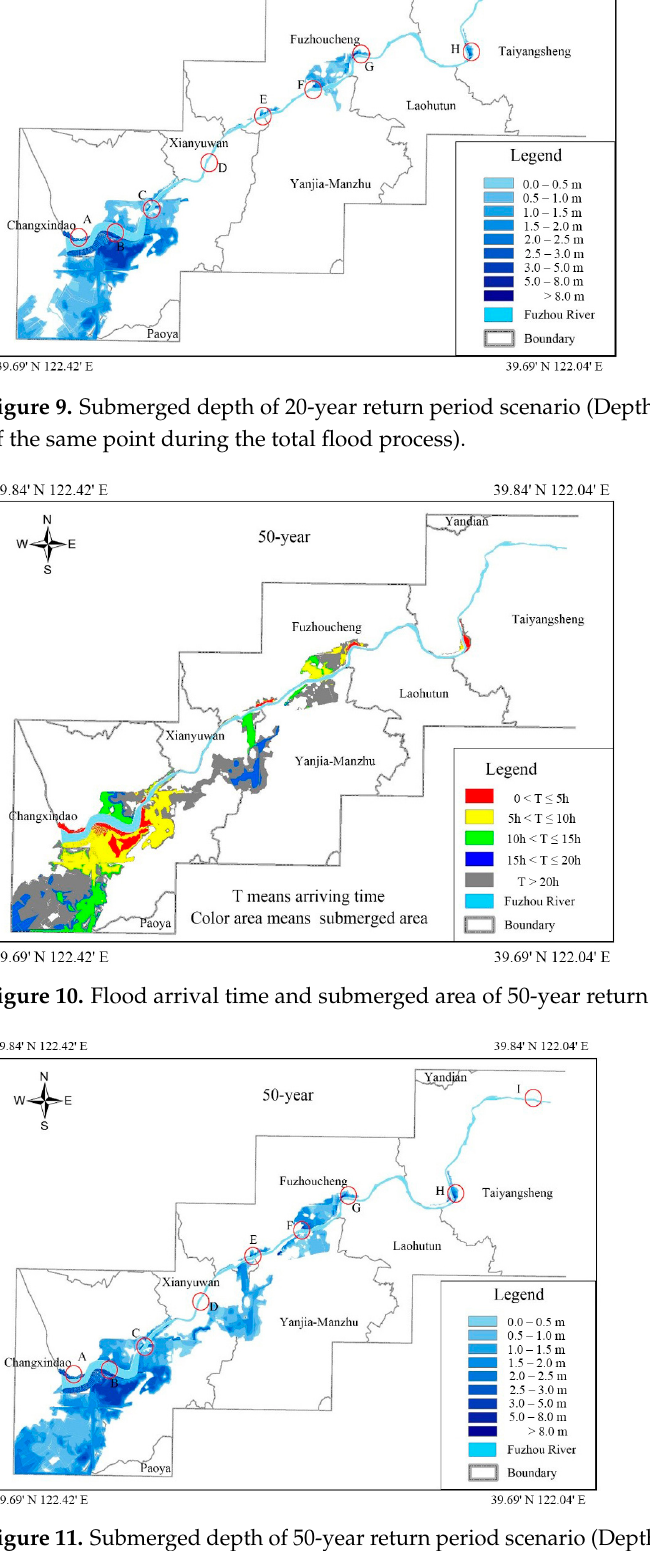
Figure 11. Submerged depth of 50-year return period scenario (Depth in here means maximum depth of the same point during the total flood process).